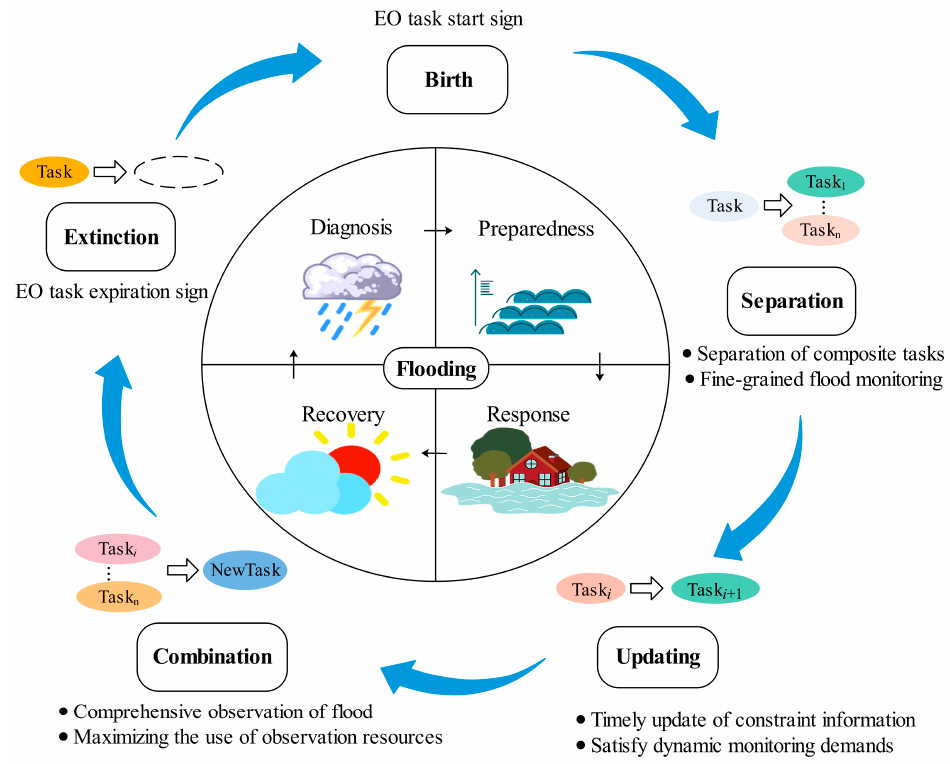
Figure 3. Full life cycle of an earth observation task.